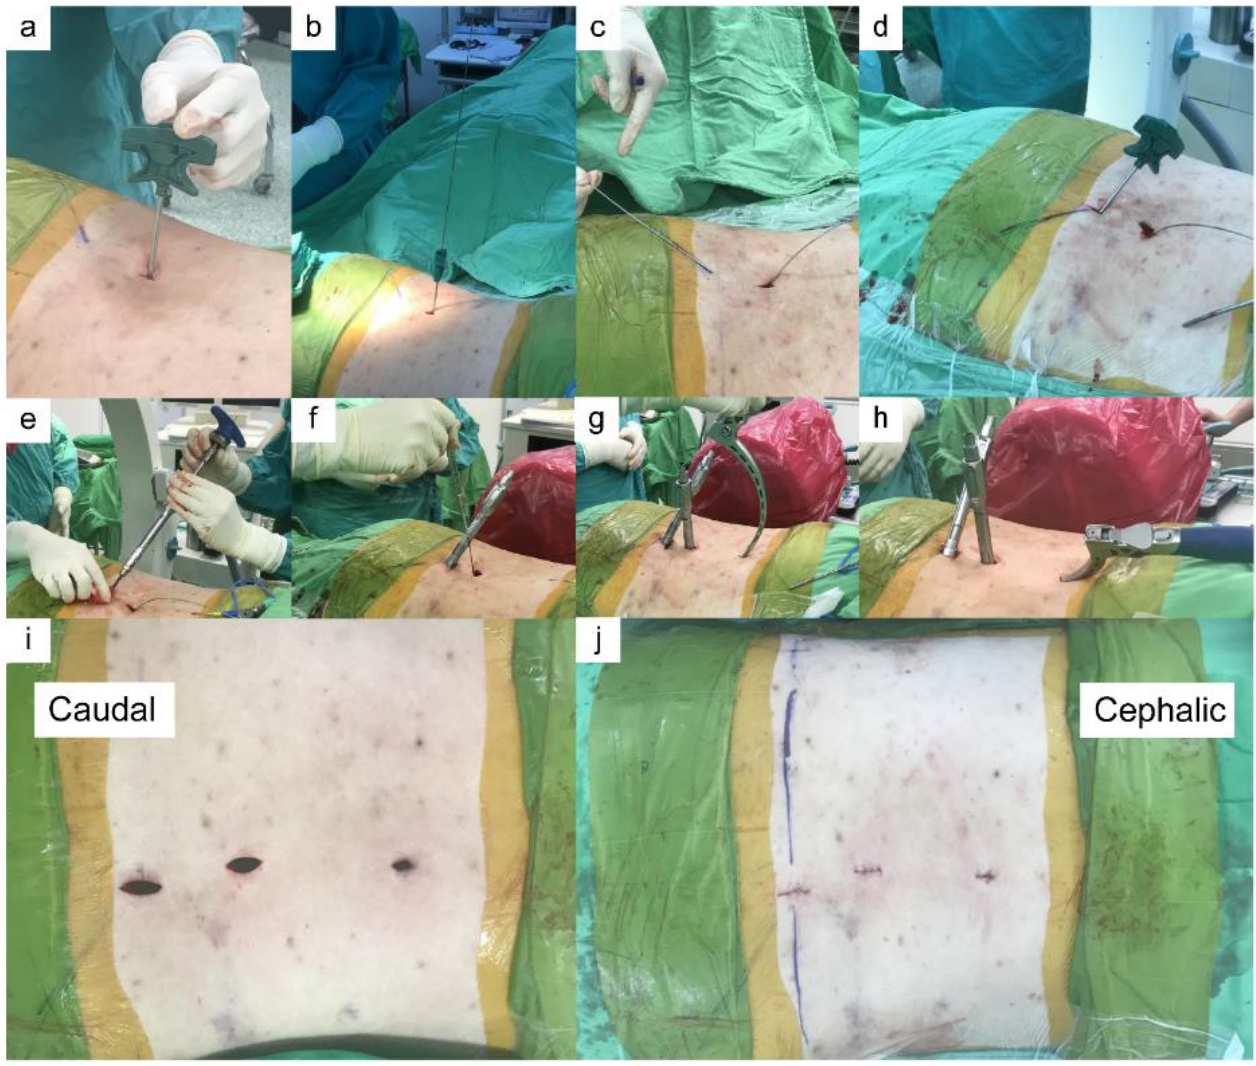
Figure 1. ( a ) The entry point of the pedicle screw is determined using a Jamshidi needle under fluoroscopic guidance. ( b ) The Jamshidi needle is inserted into the pedicle, and a blunt guide wire is inserted through the Jamshidi needle. ( c ) The direction of iliac screw is determined with a Steimann pin under fluoroscopic guidance and a guiding line is drawn on the skin. ( d ) The Jamshidi needle is docked into the recess below the posterior iliac spine following the guiding line at 45 ◦ in the ventral and caudal directions toward the anterior inferior iliac spine. The blunt guiding pin is placed through the Jamshidi needle. ( e ) The cannulated iliac screw is inserted. ( f ) The L5 pedicle